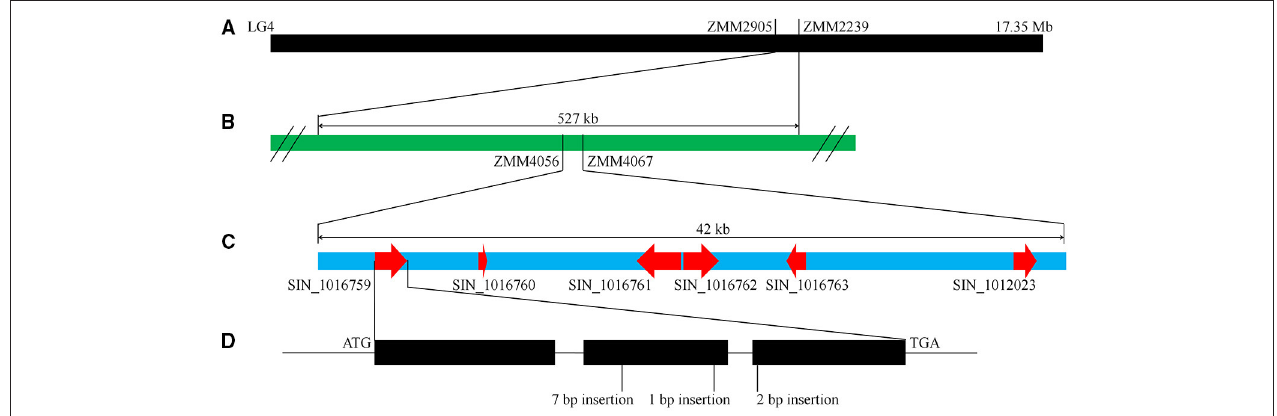
FIGURE 5 | QTL mapping and gene identification of seed coat color. (A) A major QTL for seed coat color was identified in LG4. (B) Fine mapping of the QTL. (C) Predicated genes in the QTL region. (D) Frameshife InDels in SIN_1016759.